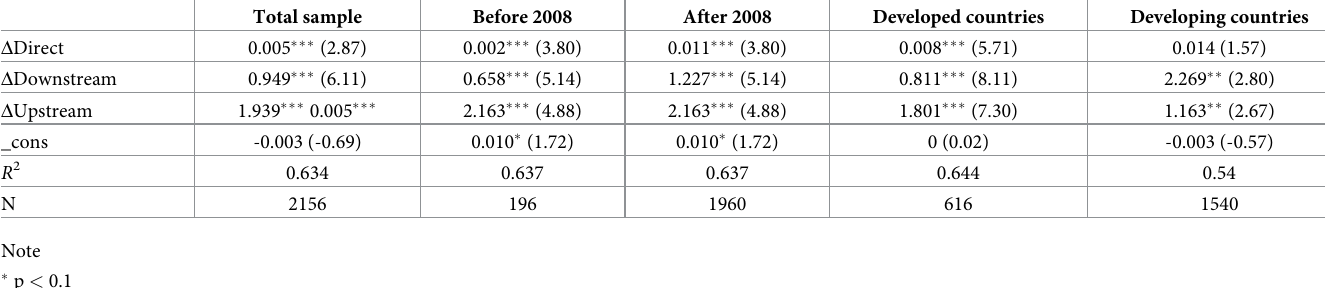
Table 6. Regression results of instrumental variable method.